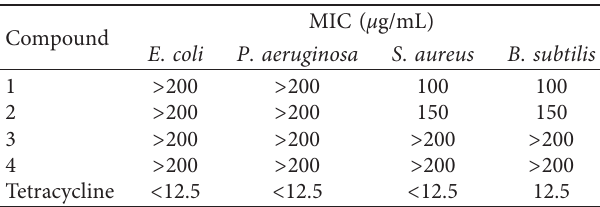
Table 2: Minimum inhibitory concentration (MIC) values ob- tained for the compounds 1 – 4 and tetracycline against Gram- positive ( Staphylococcus aureus and Bacillus subtilis ) and Gram- negative (Escherichia coli and Pseudomonas aeruginosa ) bacterial